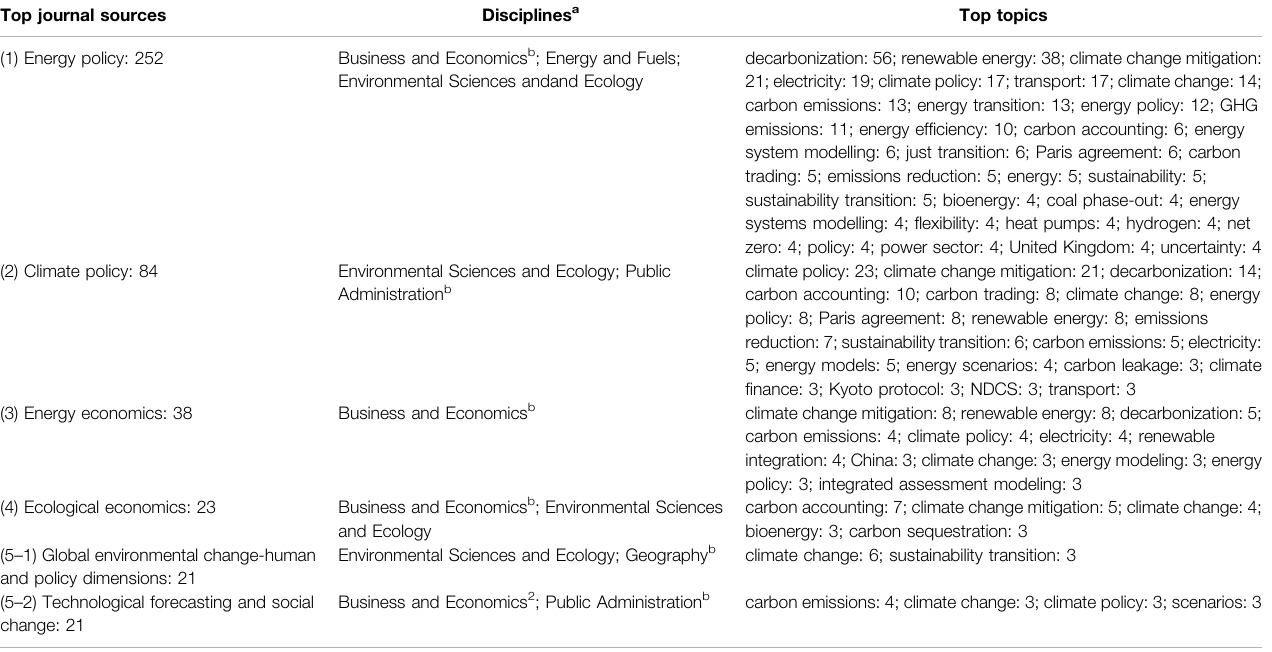
TABLE 4 | Top journal sources and their respective disciplines and topics.